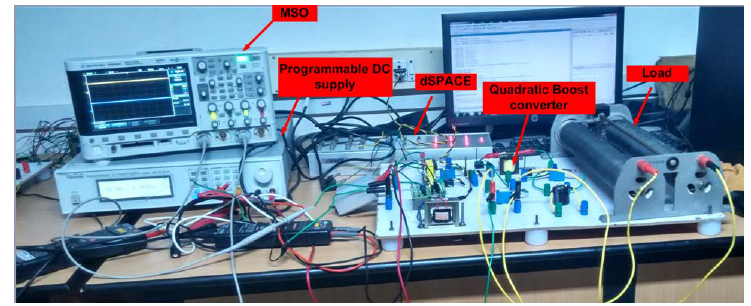
Figure 12. Generated output parameters of permanent magnet synchronous generator (PMSG), ( a ) voltage; ( b ) current.